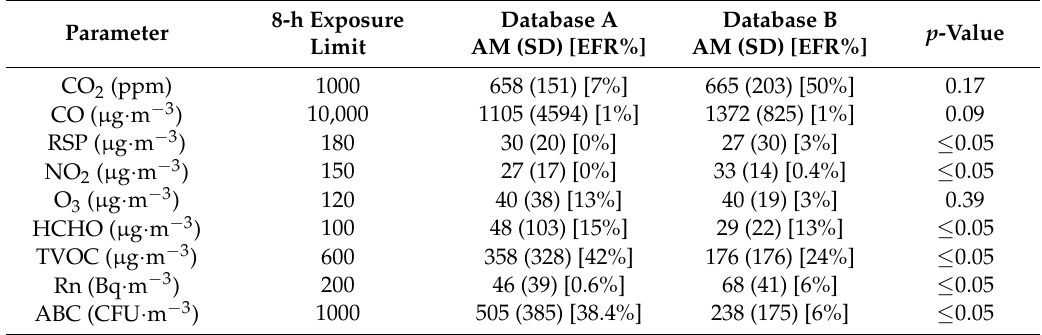
Table 1. Indoor air quality (IAQ) assessment parameters for air-conditioned offices in Hong Kong. 8-h Exposure Parameter Limit